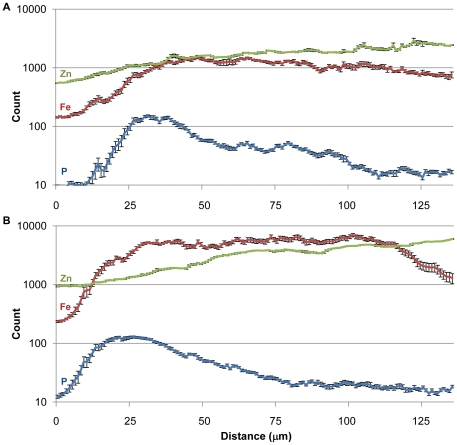
Line scans for P, Fe and Zn in WT (A) and OE-OsNAS2A (B) grain.Line scans begin on the outer margin of grain and continue 135 µm towards the endosperm; data is displayed as average count (mean ± SE, n = 23). Counts are plotted on logarithmic scale in the y-axis to account for the low P counts (blue) relative to Fe (red) and Zn (green). As the rice grain contains a single aleurone layer that is rich in phosphorus (P, primarily in the form of phytic acid) while endosperm contains little P, 1–50 µm was assigned to the aleurone layer, 51–90 µm to the subaleurone layer and 91–135 µm to the endosperm.